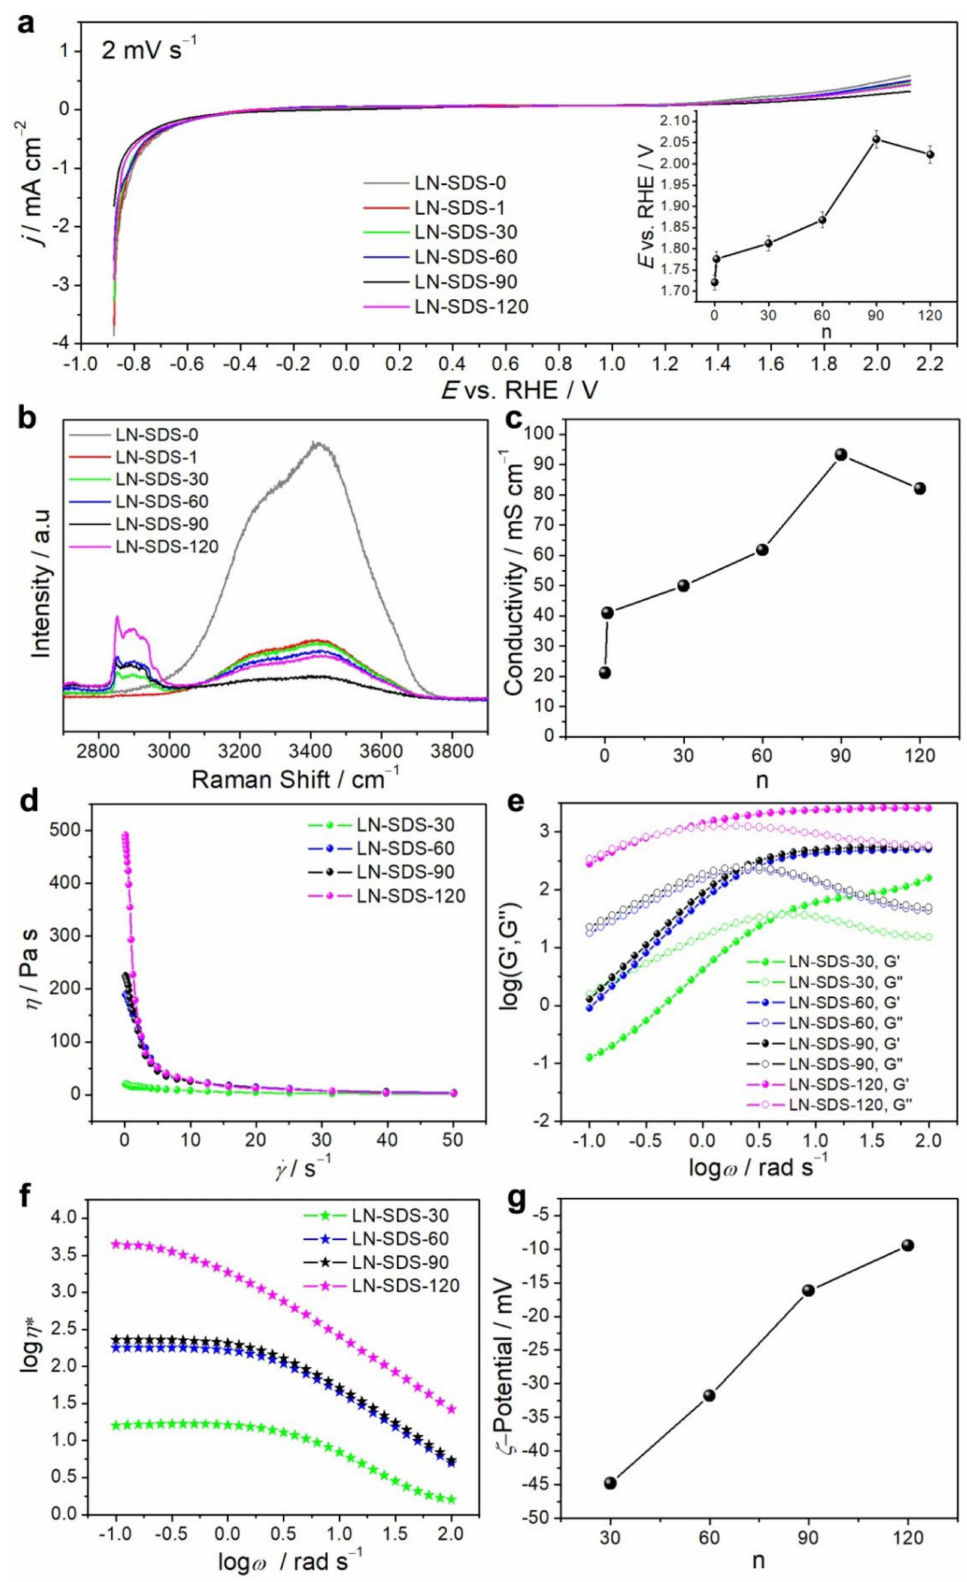
Figure 1. Room-temperature physicochemical properties of LN-SDS-n: ( a ) LSV plots, inset is the ESW plot with relative standard deviation (RSD) of ca. 1%, ( b ) Raman spectra, ( c ) ionic conductivity plot, ( d ) shear viscosity plots vs. shear rate, ( e ) plots of elastic modulus and viscous modulus vs. angular frequency, ( f ) plots of complex dynamic viscosity vs. angular frequency, and ( g ) ζ -potential